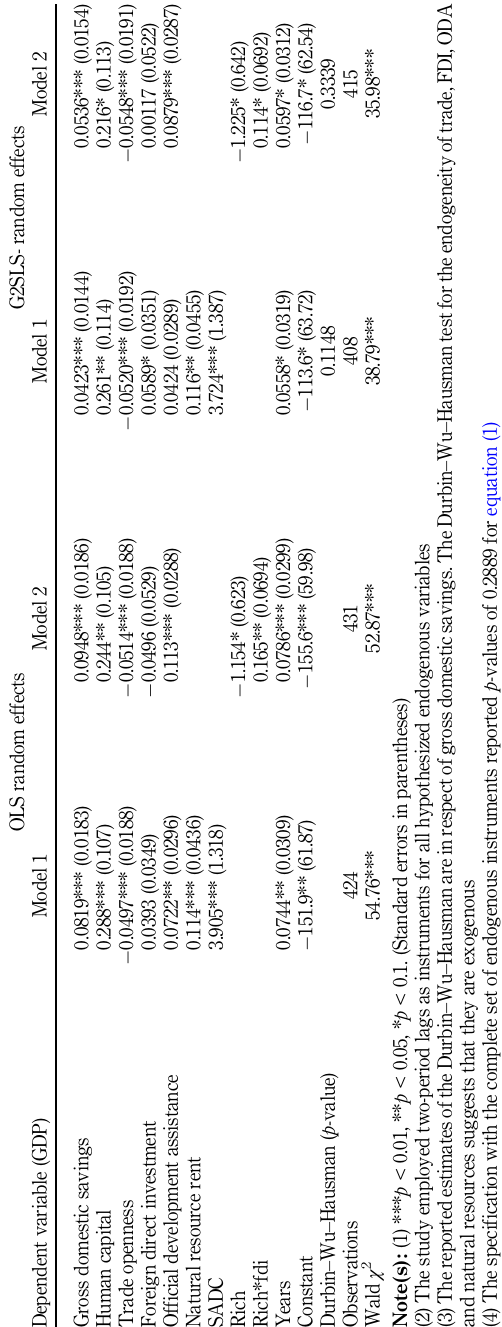
Table 3. Empirical estimates of economic growth in